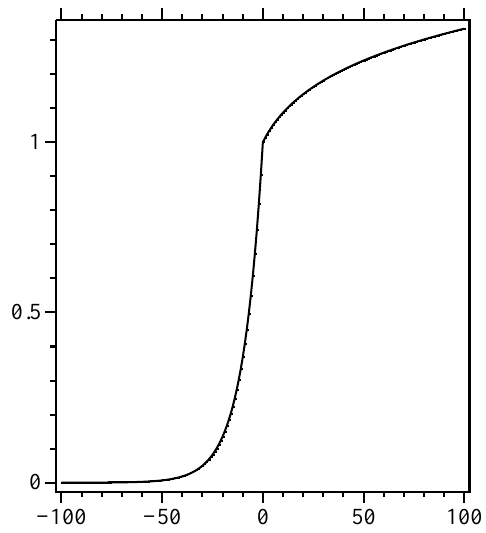
Figure 1. Local relative electron density n e (x,y)/n o as function of local potential V (x,y) for ν = 0 . 12, by Eqs. (1) and (2). The electron temperature is T e = 10eV.